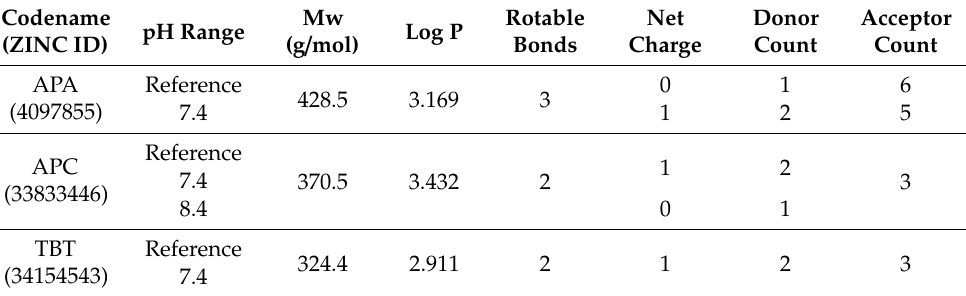
Table A1. Chemical characteristics of A. spruceanum studied metabolites. Retrieved from ZINC.